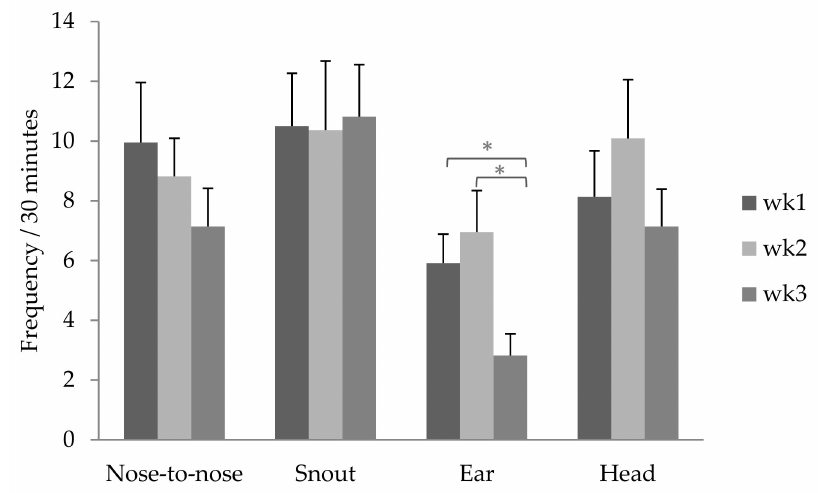
Figure 2. Average frequency of the four types of piglet-to-sow nosing behaviour ( n = 22 litters) by observation week (30 min per week). Values are LS-means with SE. * significant di ff erence indicated by p <